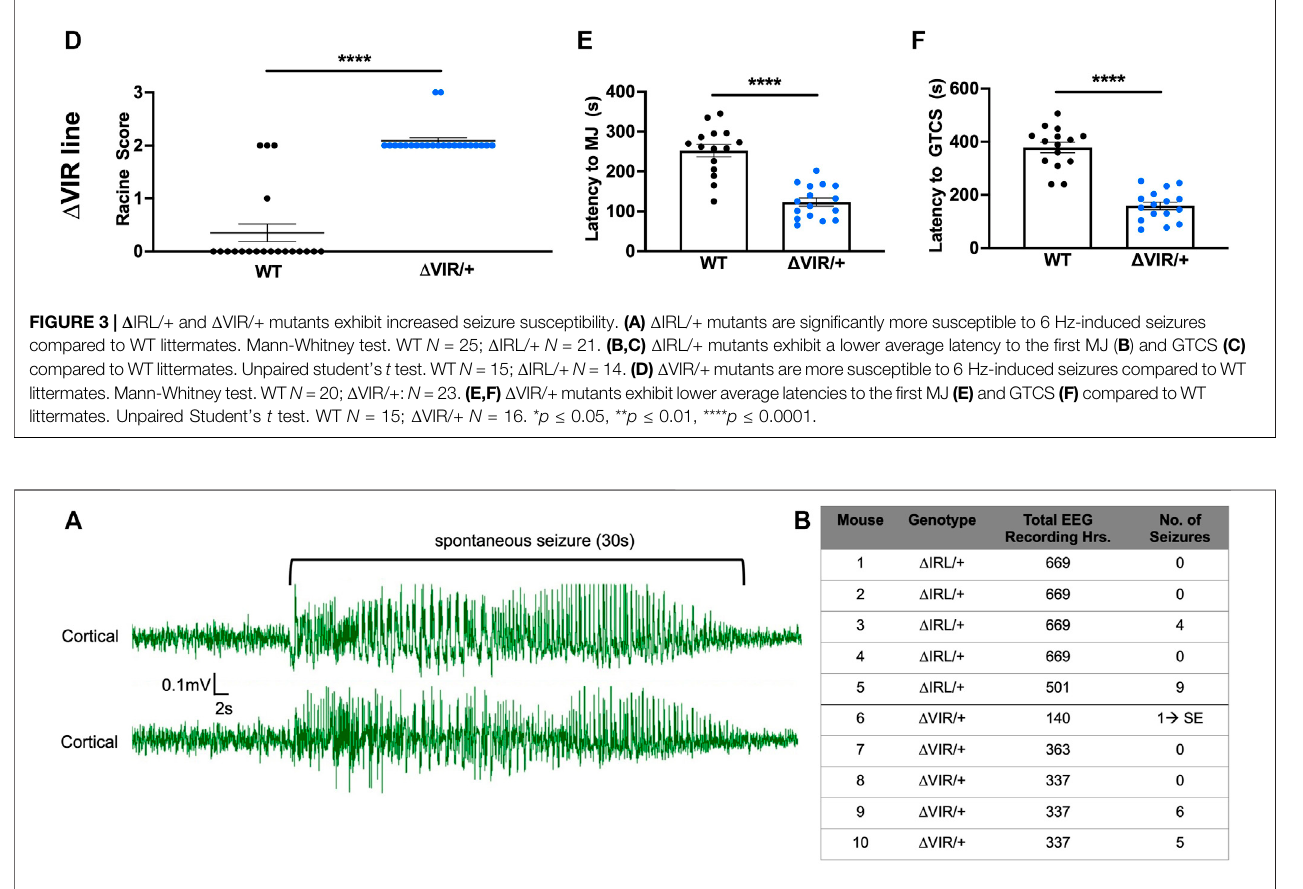
FIGURE 4 | Δ IRL/+ and Δ VIR/+ mutants exhibit spontaneous seizures. (A) Representative cortical EEG traces from a Δ VIR/+ mutant before, during, and after a spontaneous seizure. (B) Number of spontaneous seizures observed in 5 male Δ IRL/+ and 5 male Δ VIR/+ mutants. SE denotes status epilepticus.